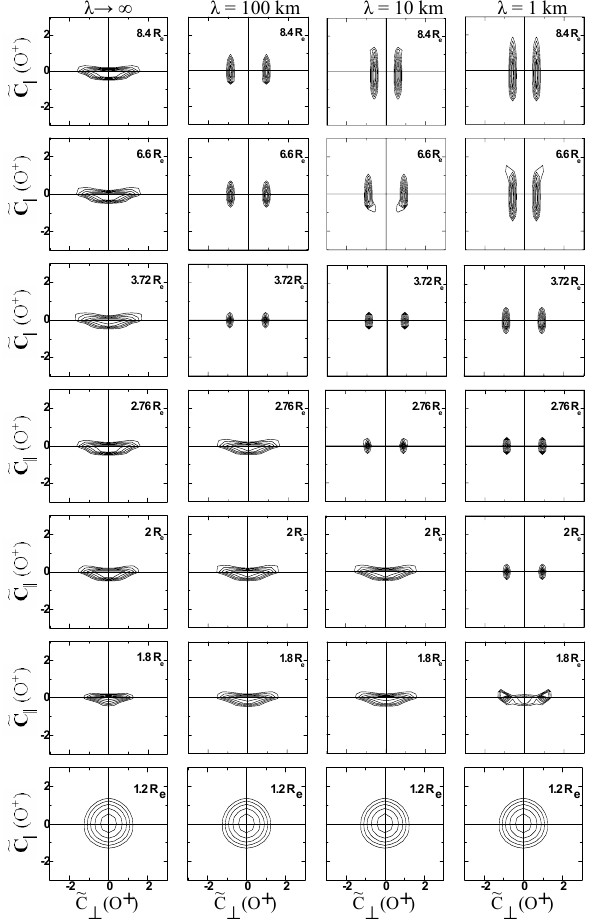
Fig. 1. O + ions velocity distribution functions at differ- ent geocentric distances (1.2, 2.0, 2.76, 3.0, 4.4, 6.6, and 7.2 R E ) for different electromagnetic turbulence wavelengths ( λ ⊥ ) , the wavelengths considered here are λ ⊥ →∞ , λ ⊥ = 100km, λ ⊥ = 10km, and λ ⊥ = 1km. f (cid:0) O + (cid:1) is represented by equal val- ues contours in the normalized velocity ( ˜ c k , ˜ c ⊥ ) plane, where ˜ c = (cid:2) v − u( O + ) (cid:3)(cid:14)(cid:2) 2 kT (cid:0) O + (cid:1)(cid:14) m (cid:0) O + (cid:1)(cid:3) 1 / 2 . The contour levels de- crease successively by a factor e 1 / 2 from the maximum.